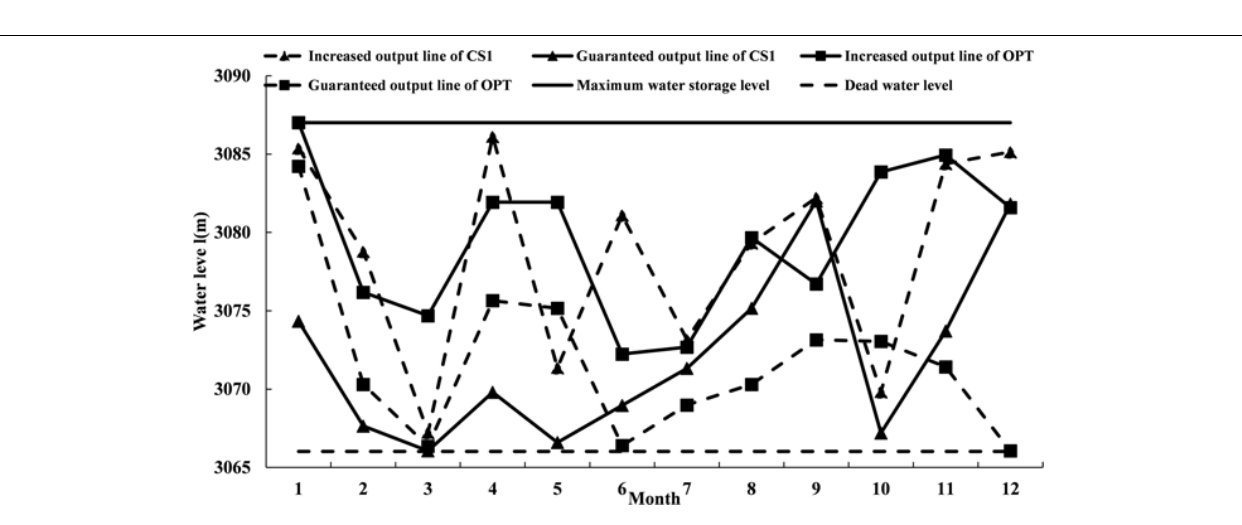
FIGURE 8 | Comparison of power generation rules between OPT and